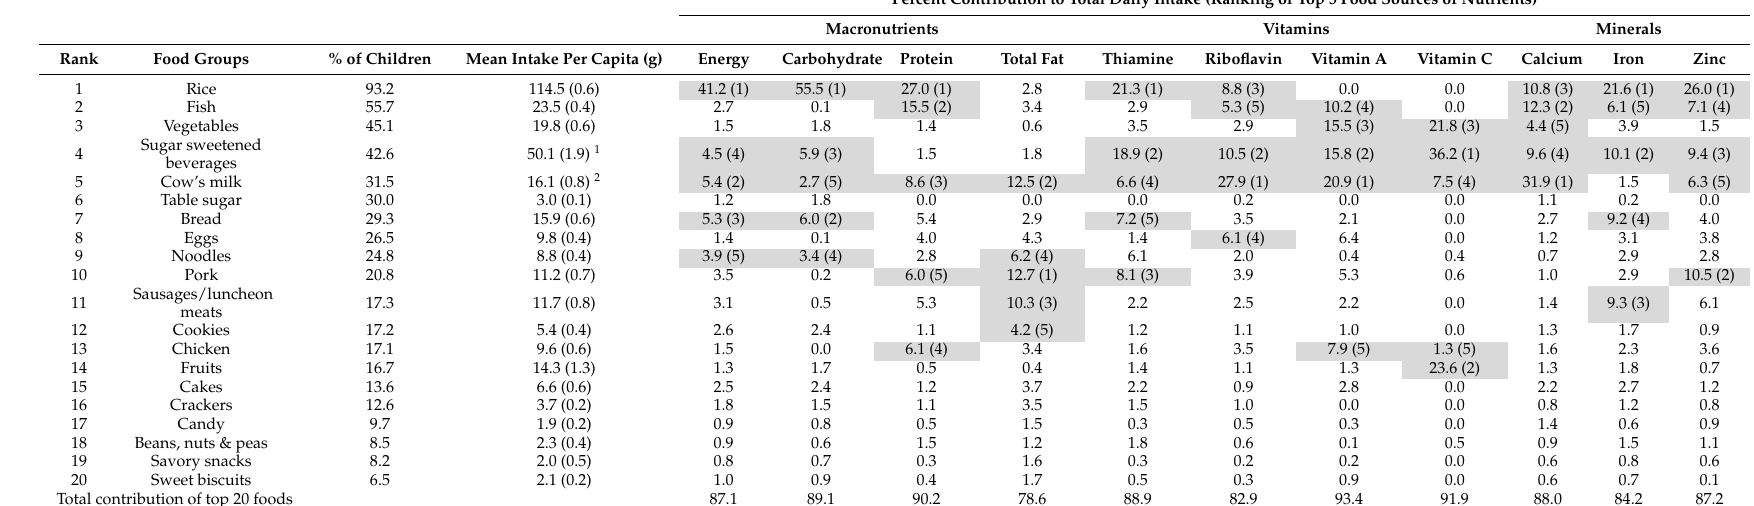
Table 10. Top-20 most consumed food groups and their contribution to energy and selected nutrient intakes among young children aged 36–59.9 months ( n = 2427) in the